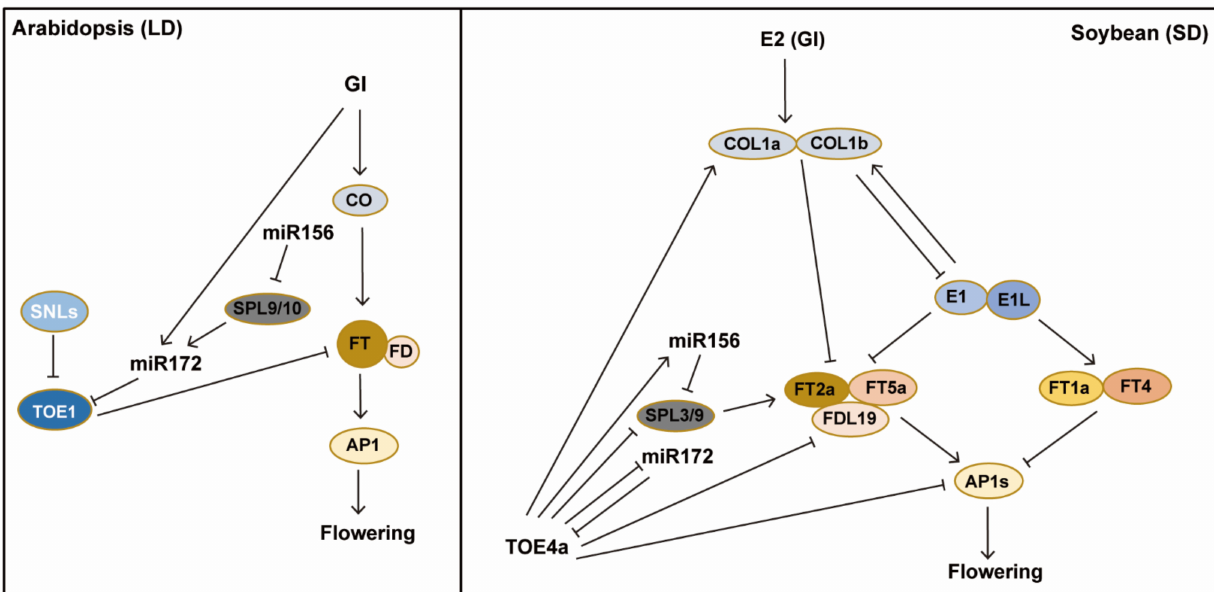
Figure 3. Comparison of photoperiodic flowering-regulatory pathways in Arabidopsis and soybean. The GI-CO-FT module is the core of photoperiodic regulation of flowering in Arabidopsis . Similarly, there is the GI (E2)-CO-FT module in soybean; in addition, there exists the GI (E2)-CO-E1-FT module in soybean. In Arabidopsis , GI regulates the expression of CO , miR172 and TOE1 , and miR172 regulates flowering through the module of GI-miR172-TOE1-FT, independent of CO; in addition, SPL9 and SPL10 directly activate miR172 expression. In soybean, GmTOE4a is not regulated by the GI homolog E2, and there are two GmTOE4a modules: TOE4a-miR156-SPL3/9-FT and TOE4a-mi172-FT . Overexpression TOE4a represses the expression of SPL3/9 . GmFT2a/5a promotes flowering, similar to the FT/FD-AP1 module in Arabidopsis, whereas FT1a/FT4 functions to repress soybean